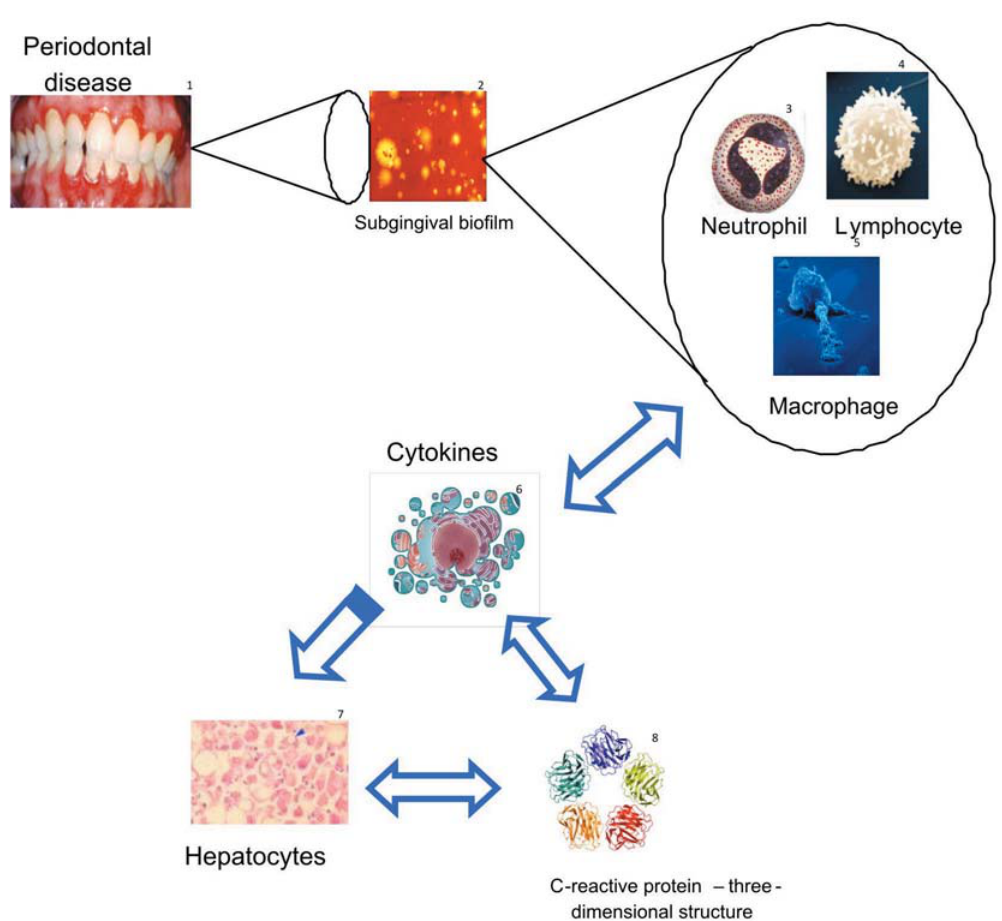
Figure 1- Biological plausibility diagram that periodontal infection may increase the serum levels of C-reactive